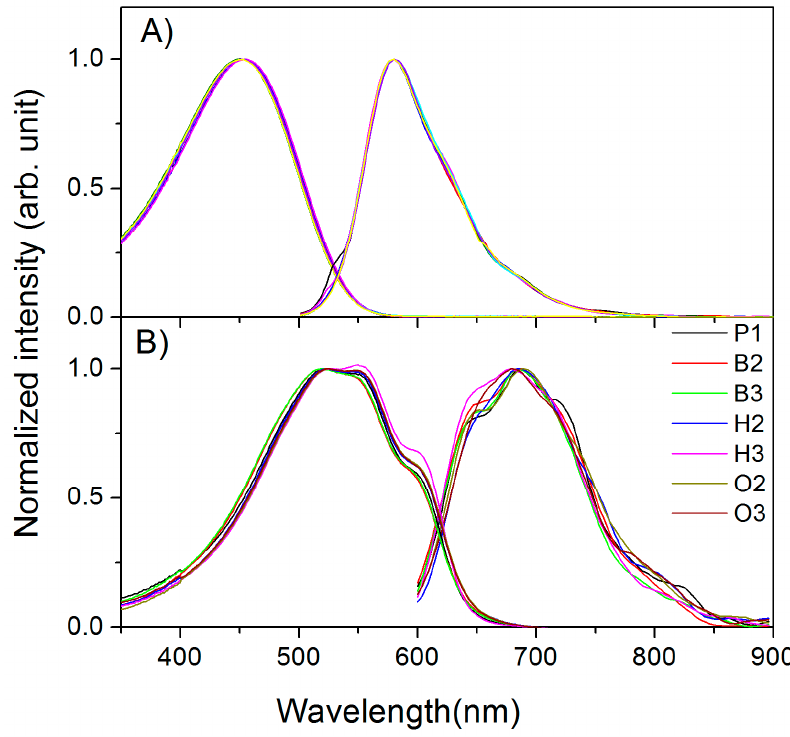
Figure 3. UV-Vis absorption and PL spectra of copolymer; ( A ) solution in CB, ( B ) pristine thin films.